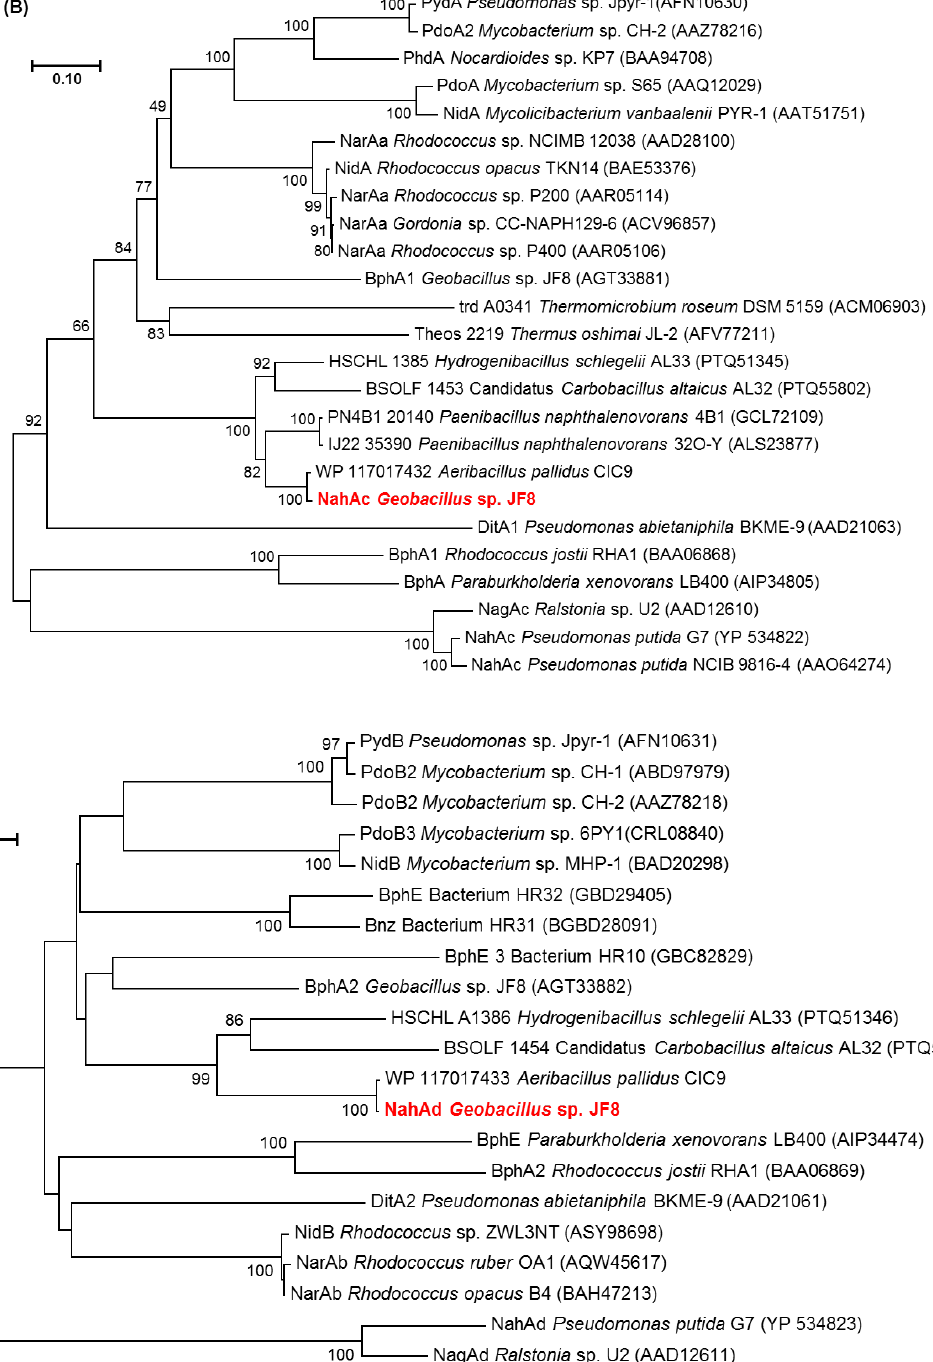
Figure 3. Neighbor-joining tree of amino acid sequences of ( A ) NahAc, ( B ) NahAd, and ( C ) NahB of JF8 (shown in red) with representative homologous proteins in mesophilic- and thermophilic-degraders. Bootstrap values (1000 replications) are shown as percentages at nodes. The tree was reconstructed using MEGA software. Bar, 0.1 substitutions per amino acid position.